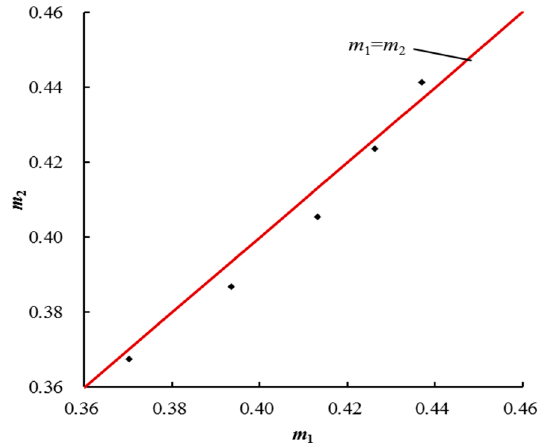
Figure 8. Comparison between m 1 and m 2 .